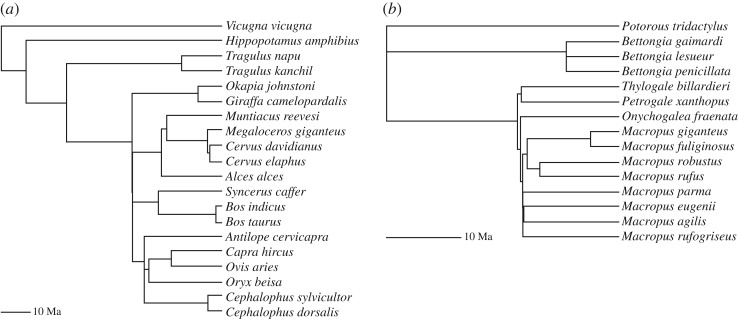
Cladograms illustrating phylogenetic relationships (from Bininda-Emonds et al. [41]) among the artiodactyl (a) and macropod (b) species used to perform phylogenetic-independent contrast calculations.